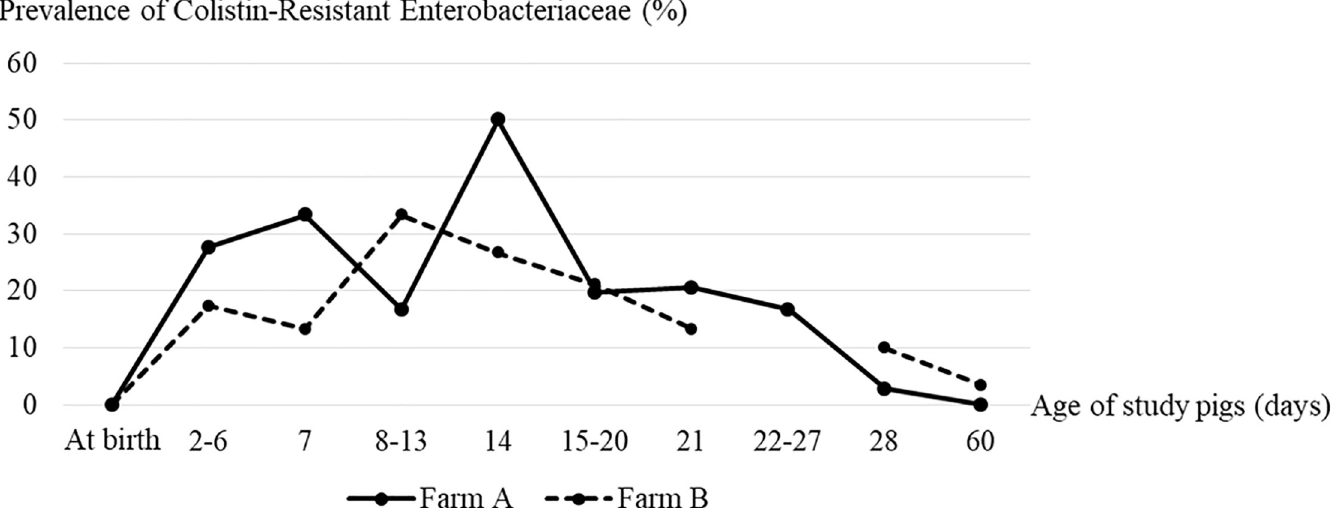
Fig 1. Prevalence of colistin-resistant Enterobacteriaceae isolates from study pigs from birth to age 60 days on Farm A and Farm B.